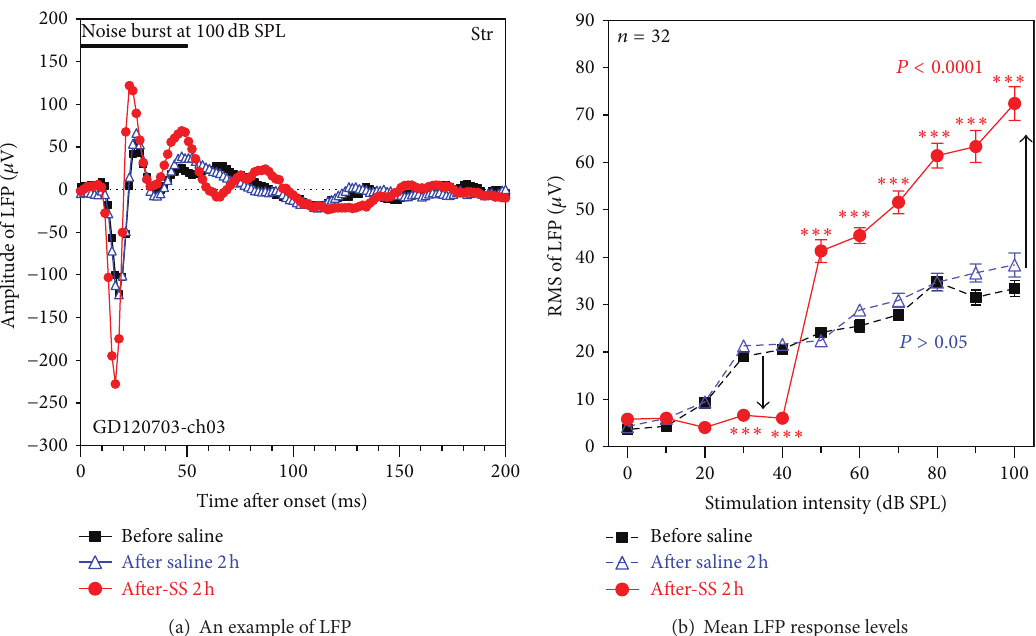
Figure 3: The effects of SS-injection on sound-evoked local field potential (LFP) elicited from electrodes in the Str. (a) An example of LFP at 100dB SPL recoded before treatment (black filled squares), after saline injection (blue open triangles), and after SS injection (red filled triangles), showing an enhanced response following SS-injection. (b) Mean RMSs of LFP ( 𝑛 = 32 ) in a time window of 100ms as a function of stimulation level, showing progressive increase of LFP amplitude at high stimulation levels but a reduction at low stimulation levels. Acoustic stimulation: 50 ms noise burst; treatments: saline (5 mL/kg, i.p.) and SS (250mg/kg, i.p.); the vertical bars are standard errors (SEs) and the ∗ ∗ ∗ means 𝑃 < 0.001 ; the arrows indicate increase and decrease of LFP amplitude.